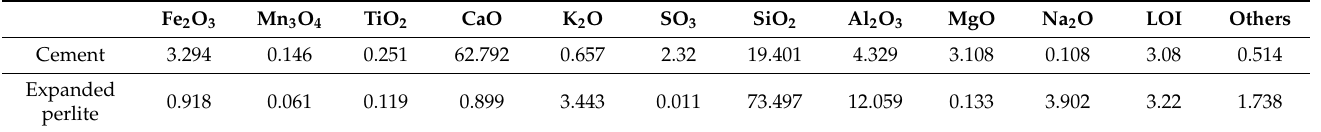
Table 1. Chemical composition of cement and expanded perlite